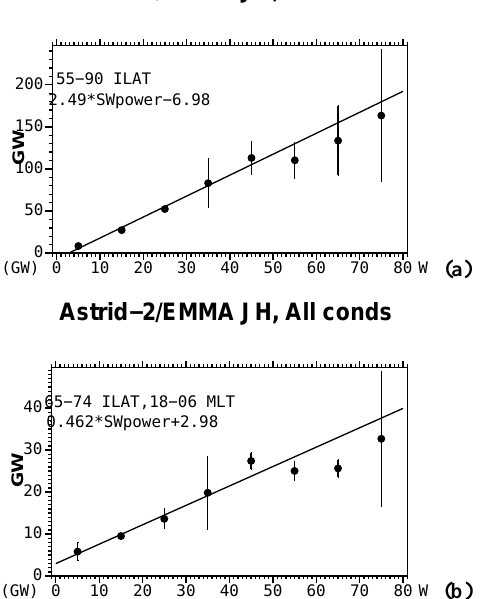
The Joule heating depending on the solar wind power parameter W (Eq. 9) for (a) ILAT 55–90, (b) ILAT 65–74. All MLT and all solar illumination conditions are included. The solid lines correspond to a fit to the data and the corresponding formula is given in each subplot, as well as in Table 3, row 2. Notice that W is defined for one hemisphere only, as is the